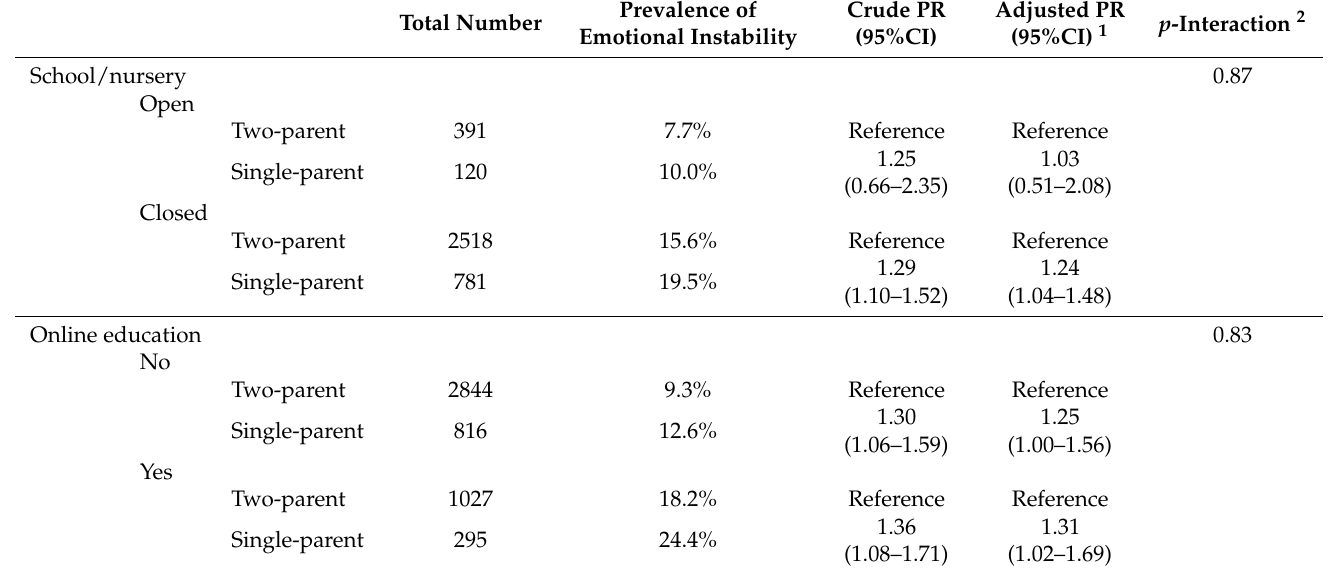
Table 4. Family type and children’s emotional instability: stratified by children’s environment and extracurricular